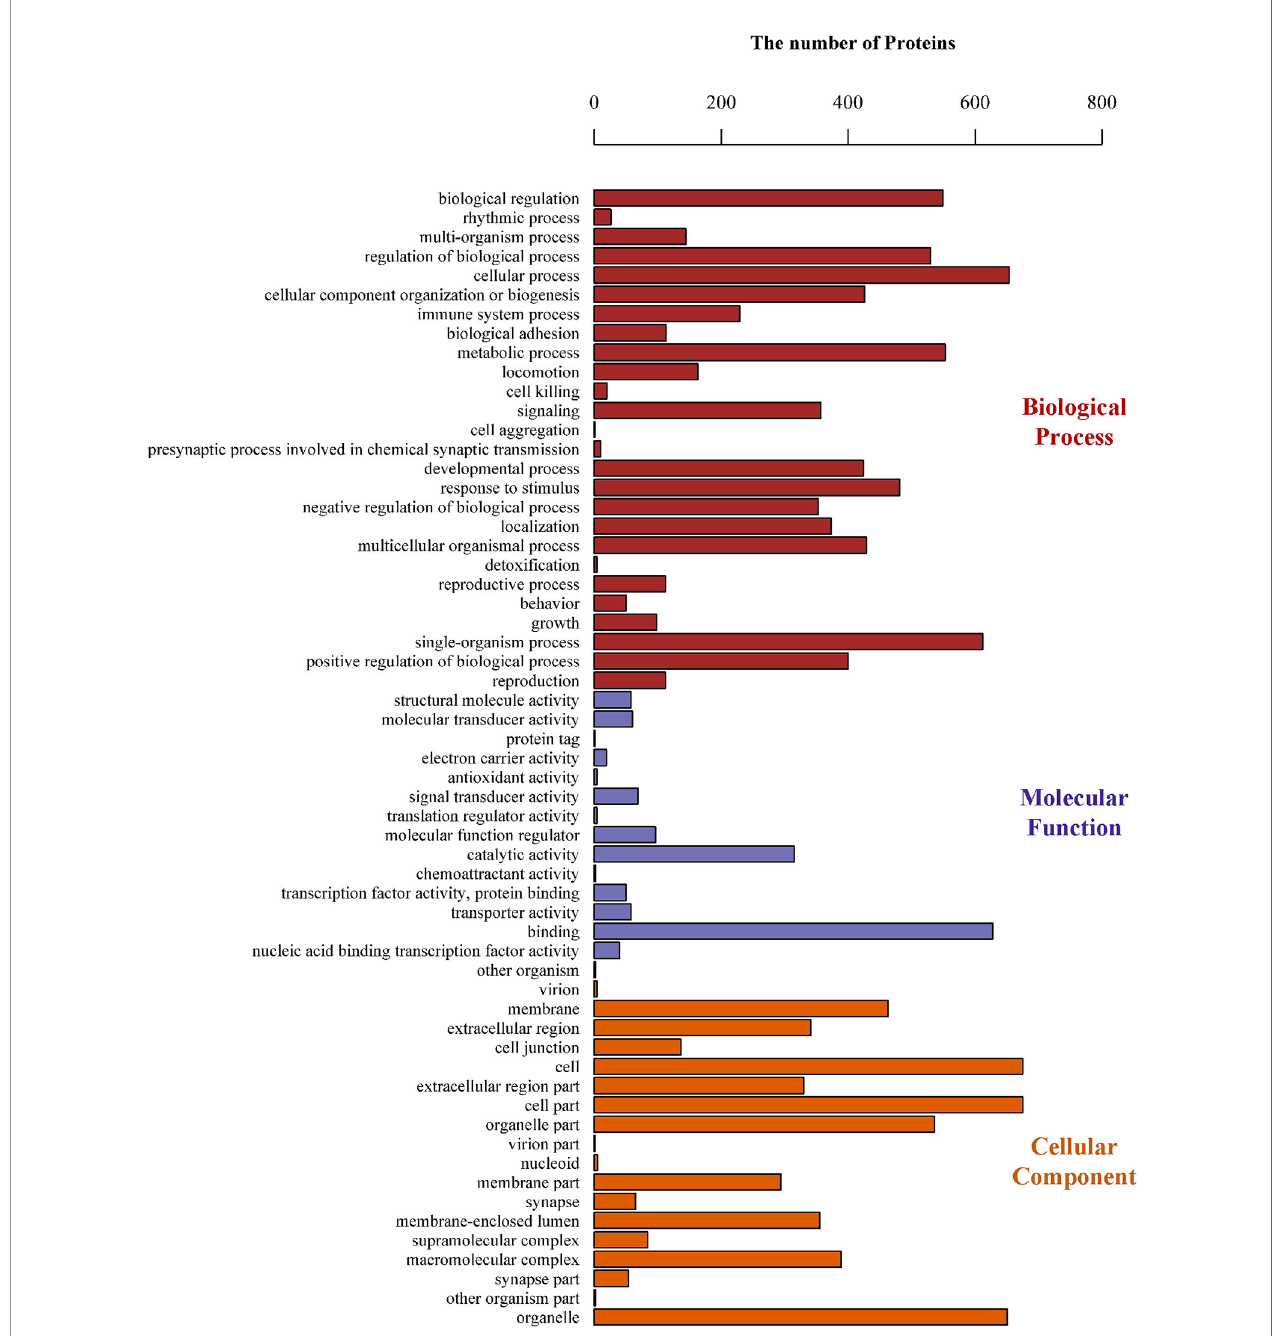
FIGURE 4 | Gene Ontology (GO) classi fi cations of the differentially expressed proteins. The number of proteins involved in each of the biological process, cellular component, and molecular function terms, which could be classi fi ed into 26, 15, and 18 subcategory groups,